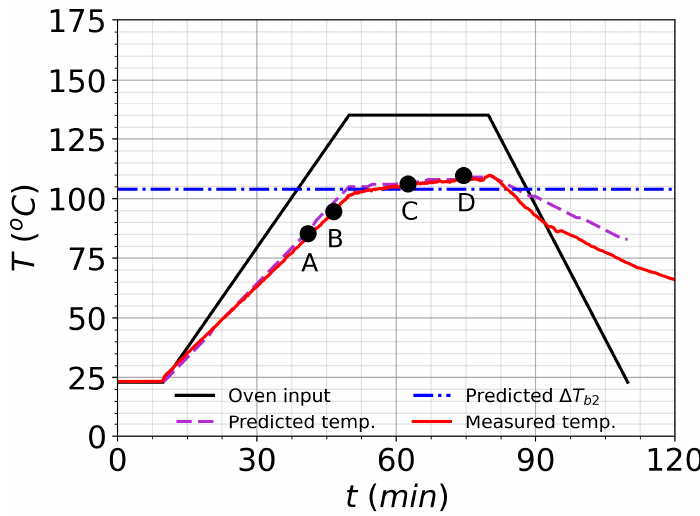
Figure 14. Heating cycle for [30/−30/5/−5] (cid:3046) composite plate.